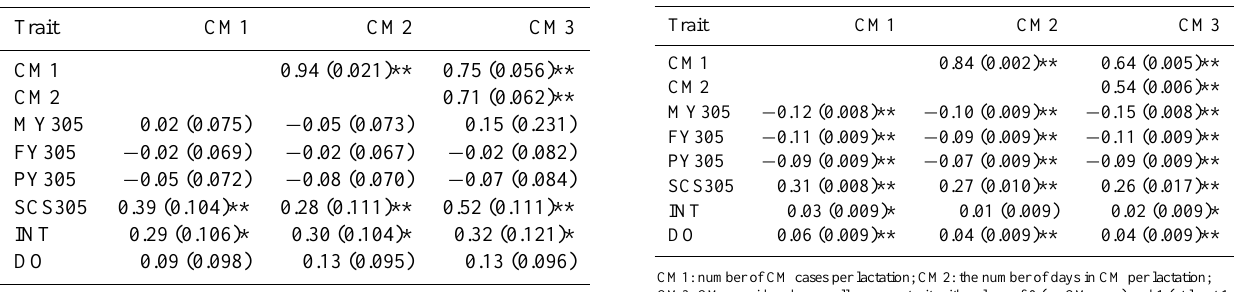
Table 5. Estimates of permanent environmental correlations be- tween CM traits, SCS, and milk production, including their standard errors (in parentheses).